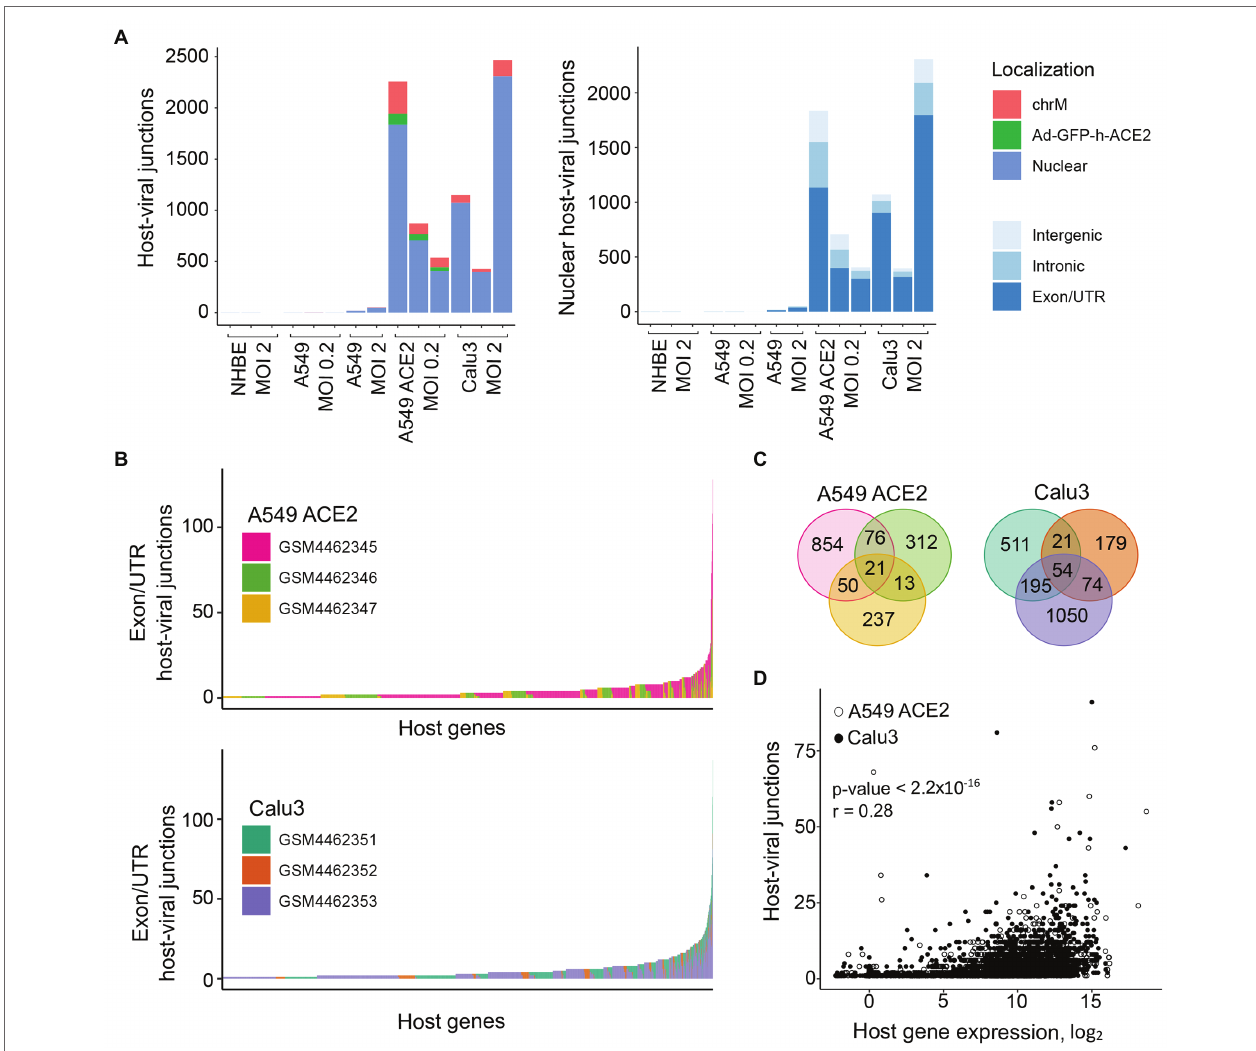
FIGURE 2 | Characteristics of human sequence part of human-SARS-CoV-2 chimeric reads. (A) Left , number of chimeric junctions identified in the indicated samples, according to the origin of the human sequence part (chrM, mitochondrial DNA; Ad-GFP-h-ACE2, ACE2-encoding adenoviral vector episomal DNA, Nuclear, nuclear DNA). Right , number of chimeric junctions where the human sequence part aligns to nuclear human DNA, according to position relative to annotated genes and exons. Each bar presents each of the triplicate samples. (B) Number of chimeric junctions located within coding regions of individual human nuclear genes in A549 ACE2 and Calu3 RNA-seq datasets. Nuclear genes donating the human sequence part are plotted on x -axis and each bar represents an individual gene, color-coded according to the triplicate sample in which it was found. (C) Overlap of host nuclear genes found in chimeric reads between the triplicate A549 ACE2 and Calu3 samples. (D) Correlation between the number of human-SARS-CoV-2 chimeric reads and the level of human donor gene